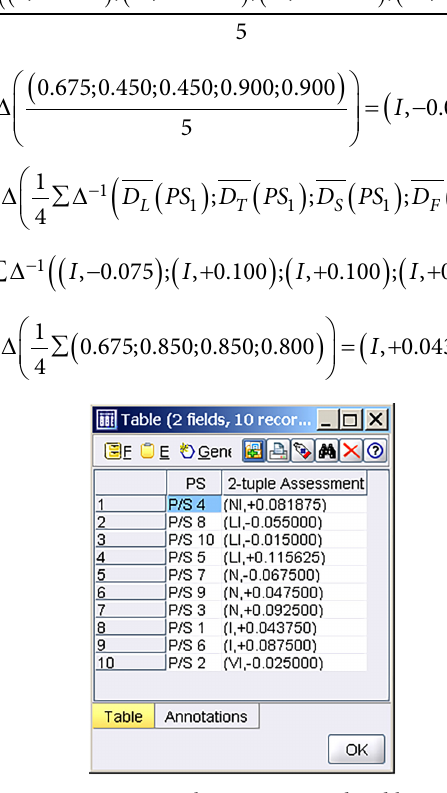
Figure 4. Final assessments ordered by importance level of the input